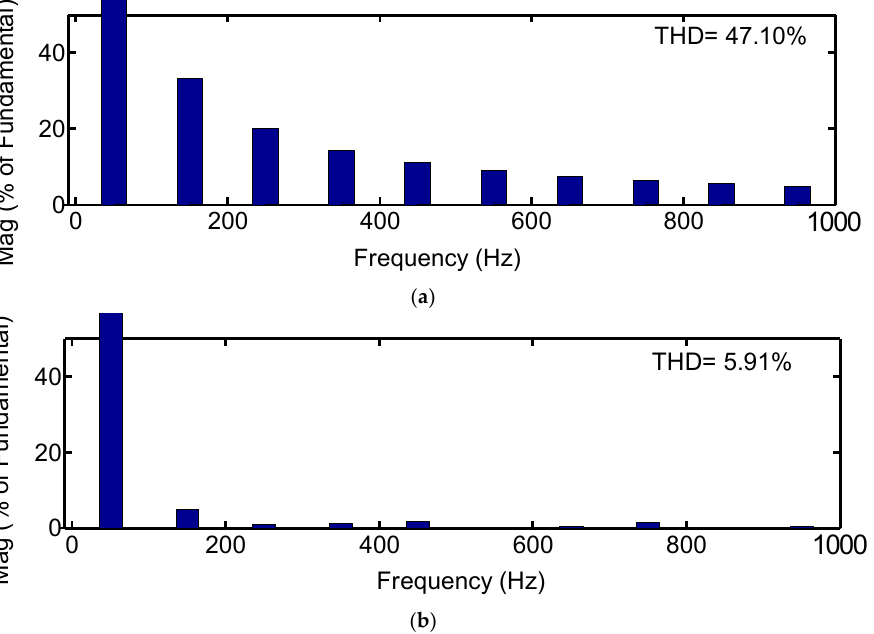
Figure 28. Spectrum distribution of the output voltage under λ = 1. ( a ) Spectrum distribution of the output voltage for a traditional MMC. ( b ) Spectrum distribution of the output voltage for the proposed hybrid MMC.